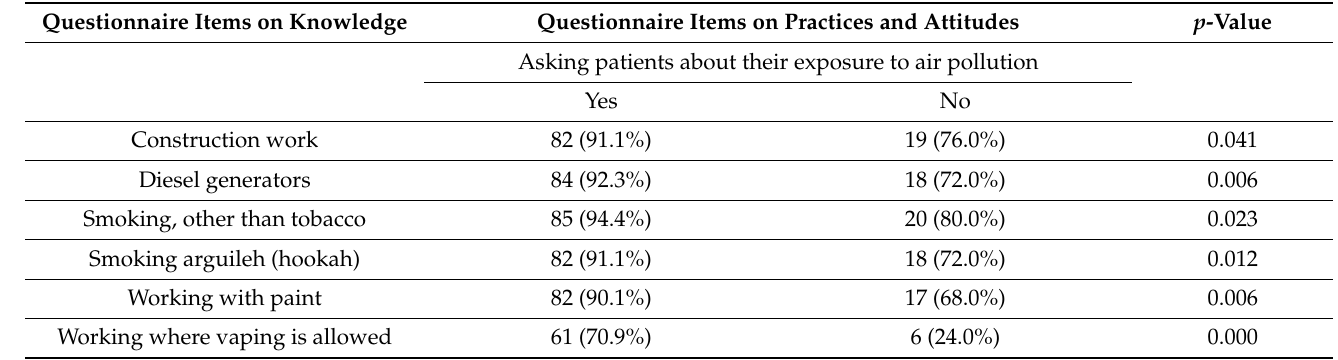
Table 6. Distribution of answers on air pollution knowledge according to the practices and attitudes of